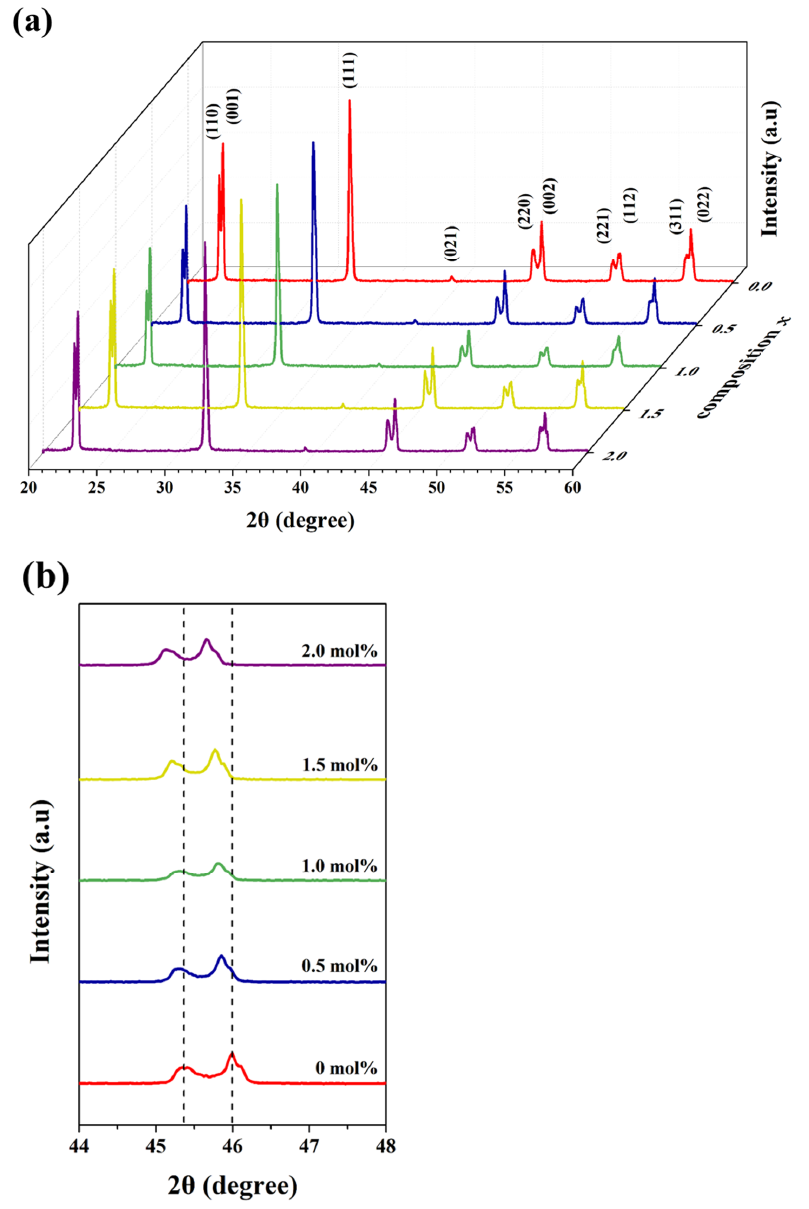
Figure 1. XRD diffraction patterns of NKLNTS-ST- x CuO ceramics at room temperature in the 2 θ range of ( a ) 20~60° ( b ) 44~48°.